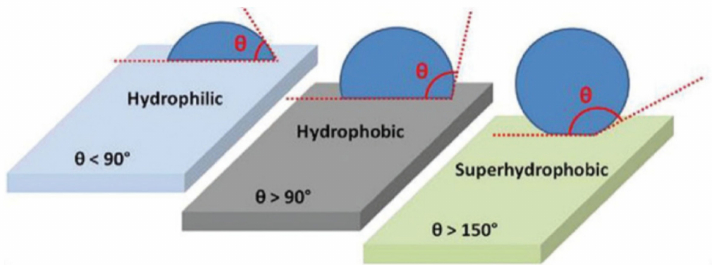
Figure 5. A graphical illustration of hydrophilicity–hydrophobicity properties of materials as ranges of contact angles [86,164]. Copyright MDPI, Basel, Switzerland—under the terms and conditions of the Creative Commons by Attribution (CC-BY) license;